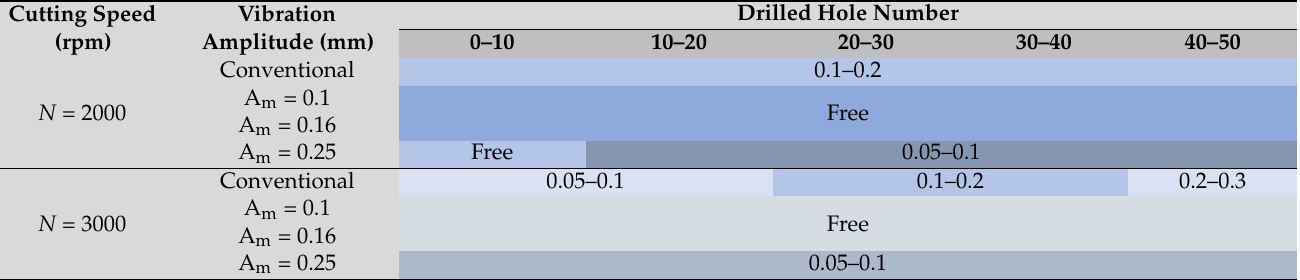
Drilled Hole NumberCutting